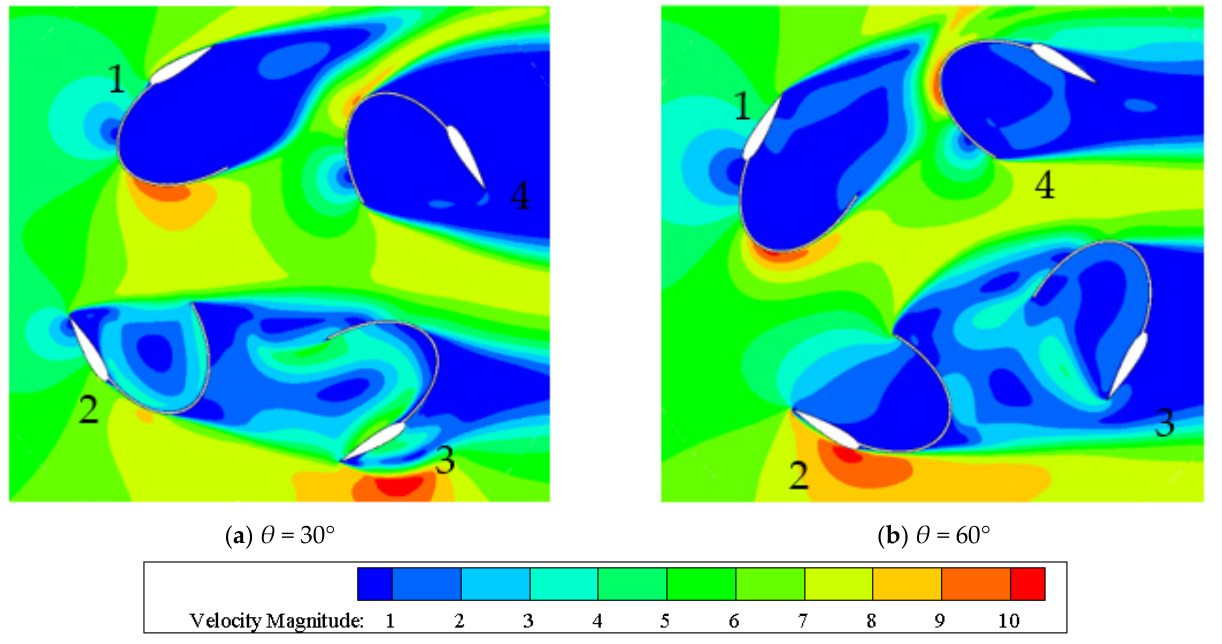
Figure 17. Velocity magnitude of 4-bladed LDCS ( U = 6 m/s): ( a ) θ = 30°; ( b ) θ = 60°.